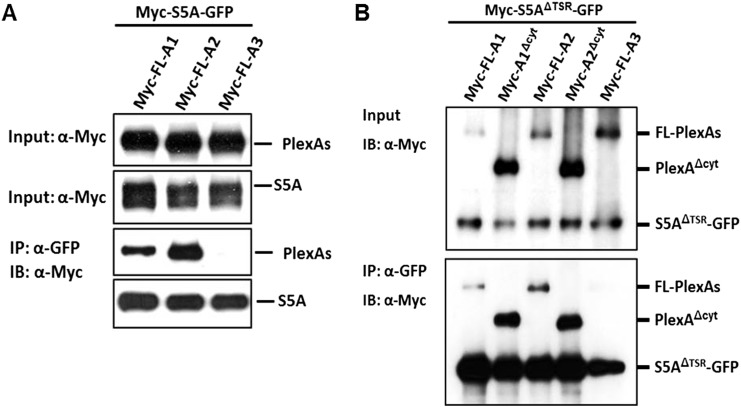
Molecular basis of Sema5A cis interaction with PlexA1 and PlexA2.(A) Cis interaction between PlexA1 or PlexA2 with Sema5A. Co-expression of Sema5A-eGFP (Myc-S5A-GFP) with myc-tagged full-length (FL) expression constructs of PlexA family members (Myc-FL-A1, Myc-FL-A2, or Myc-FL-A3) in HEK293T cells allows for co-immunoprecipitation (co-IP) of Sema5A with PlexA1 and PlexA2, but not PlexA3. (B) Myc-tagged Sema5A lacking the seven thrombospondin type1 repeats was C-terminally fused to GFP (Myc-S5AΔTSR-GFP) and co-transfected into HEK293T with FL PlexA1, PlexA2, PlexA3, or PlexA1 and PlexA2 deletion constructs lacking the cytoplasmic domain (Myc-FL-A1Δcyt or Myc-FL-A2Δcyt). Immunoprecipitation with anti-GFP followed by anti-myc immunoblotting (IB) demonstrates an interaction between the Sema5A sema domain and the PlexA1 and PlexA2 ectodomains, but not the PlexA3 ectodomain.